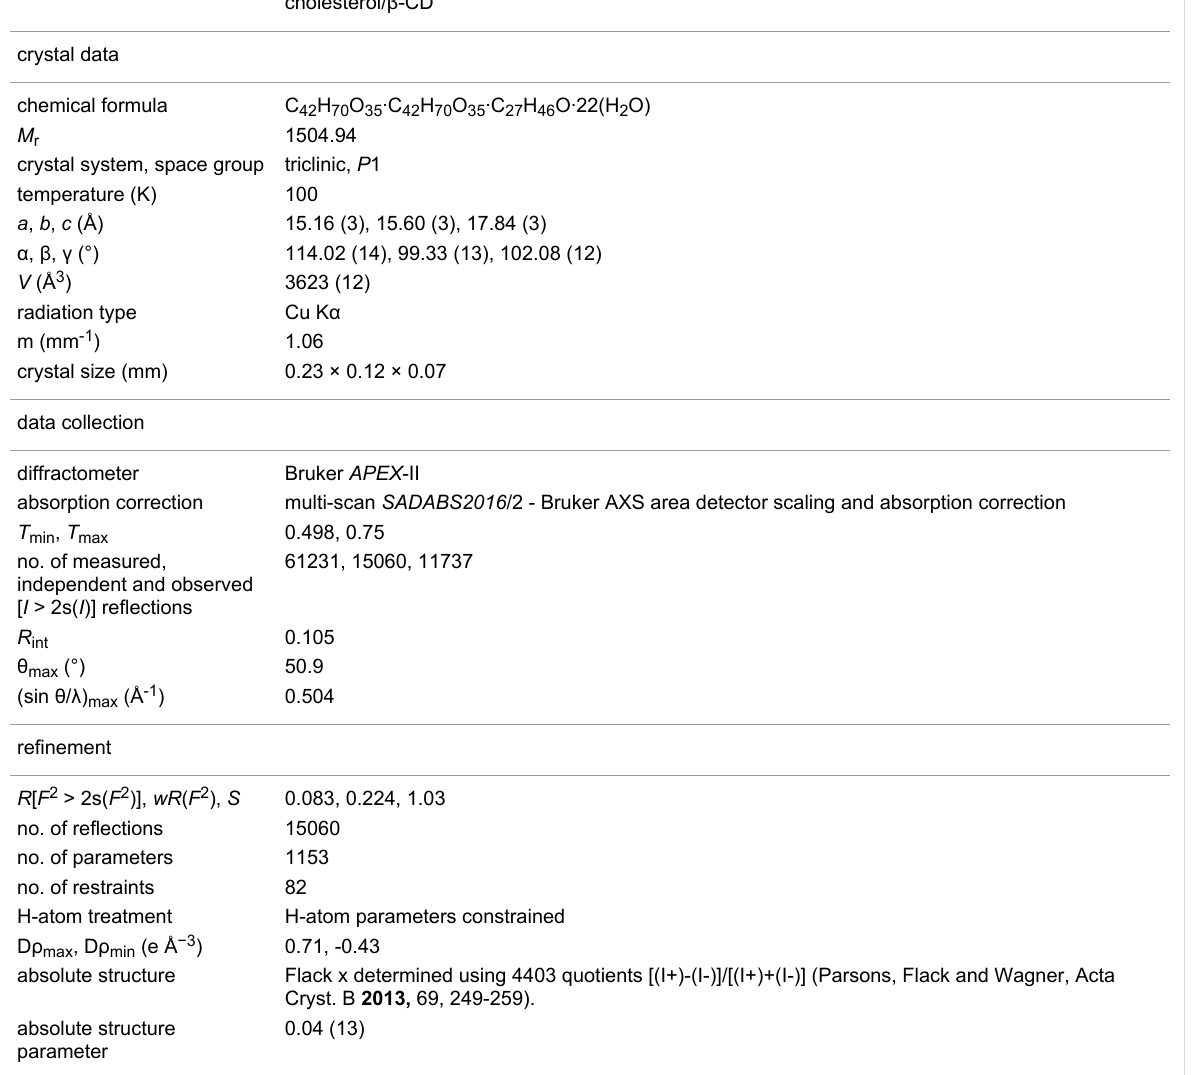
Table 1: Experimental details for the cholesterol/ β -CD inclusion compound. cholesterol/ β